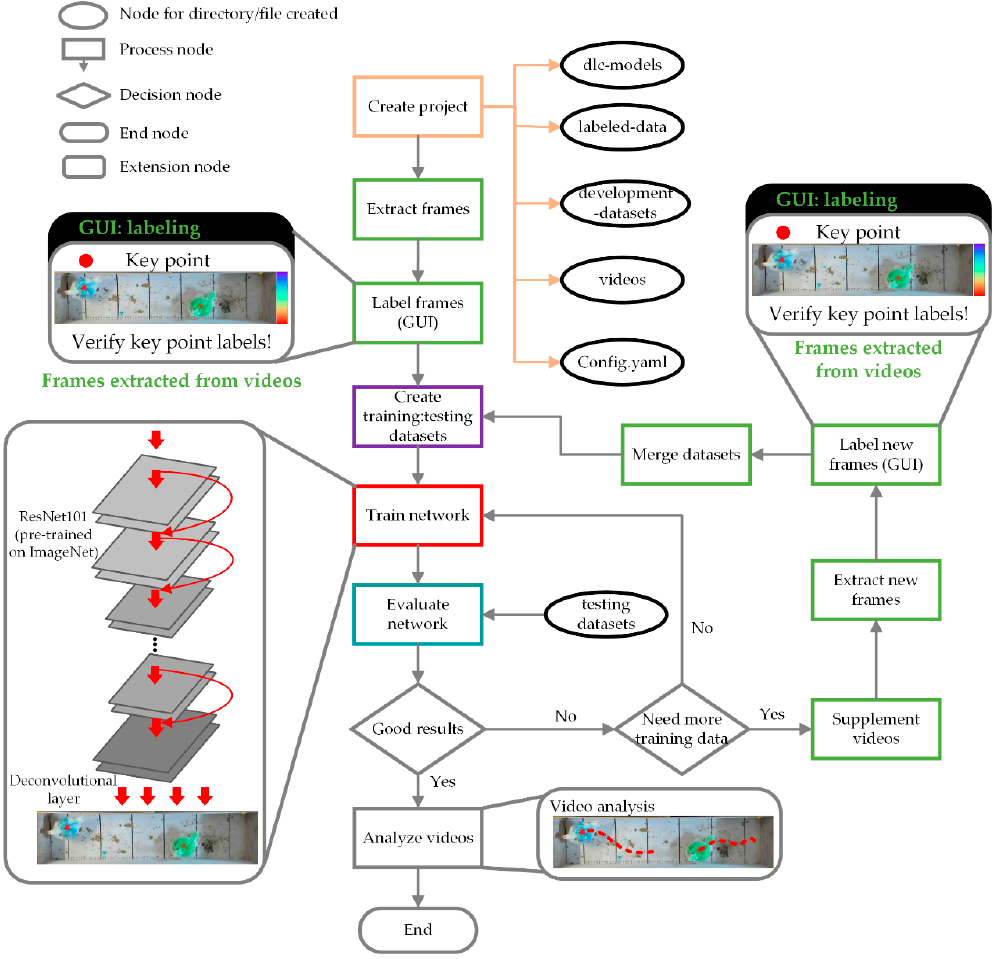
Figure 3. Flowchart for video processing using the deep-learning framework, DeepLabCut. Dlc is the abbreviation of DeepLabCut, and GUI is graphical user interface. Red arrows indicate the directions of processing.